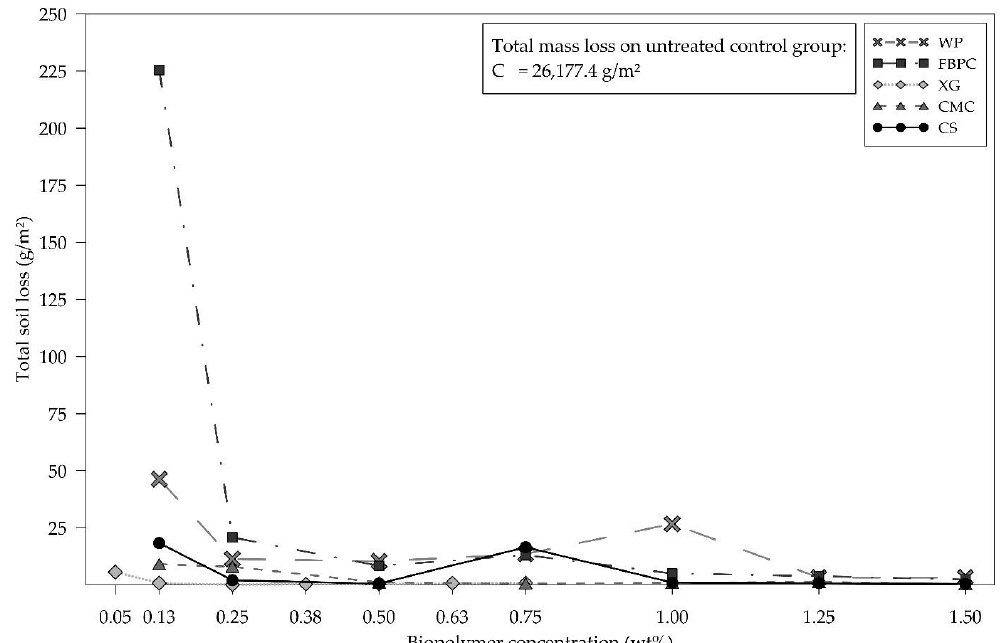
Figure 5. Total soil loss (g/m 2 ) of fine-grained silica sand samples treated with different biopolymer concentrations after the fifth wind tunnel cycle. Tests were performed in triplicate (n = 3). Note, numerical data (mean (M) and standard deviation (SD)) are appended in Table A1. Error bars representing the SD have been deliberately omitted for better legibility.